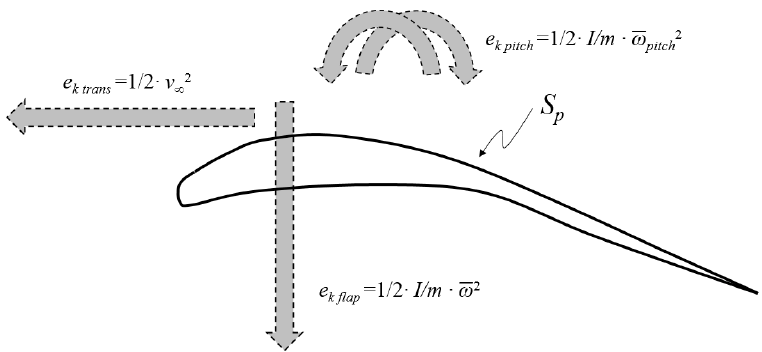
Figure 2. Three sources of kinetic energy that are physically relevant throughout the evolution towards sustained flight, translation, flapping, and cyclic wing pitch (pronation–supination).